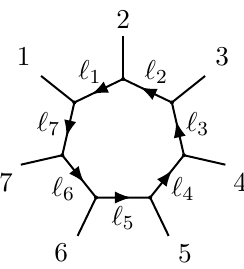
Figure 3. The loop momentum orientation of the